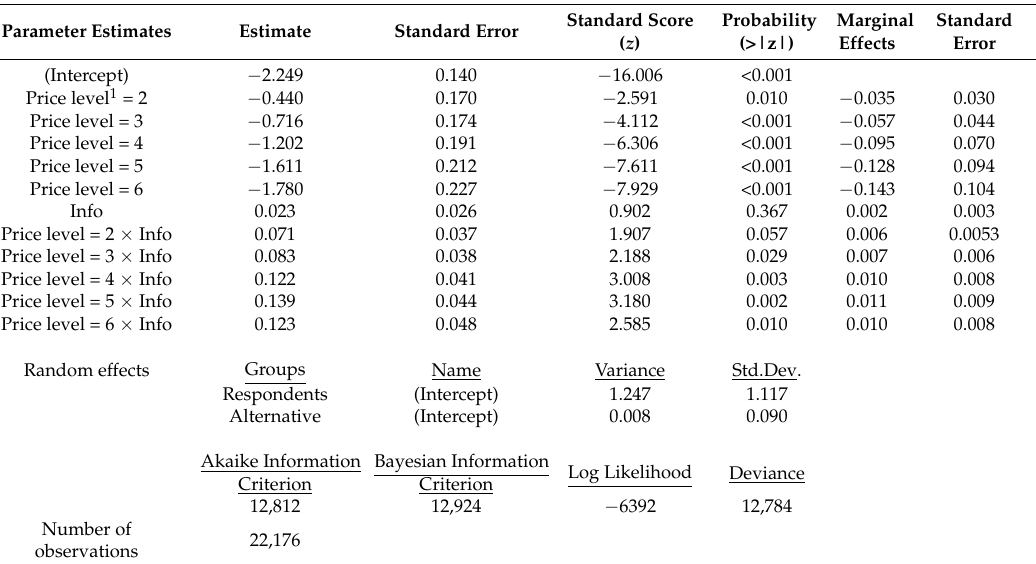
Table 6. Restricted Maximum Likelihood